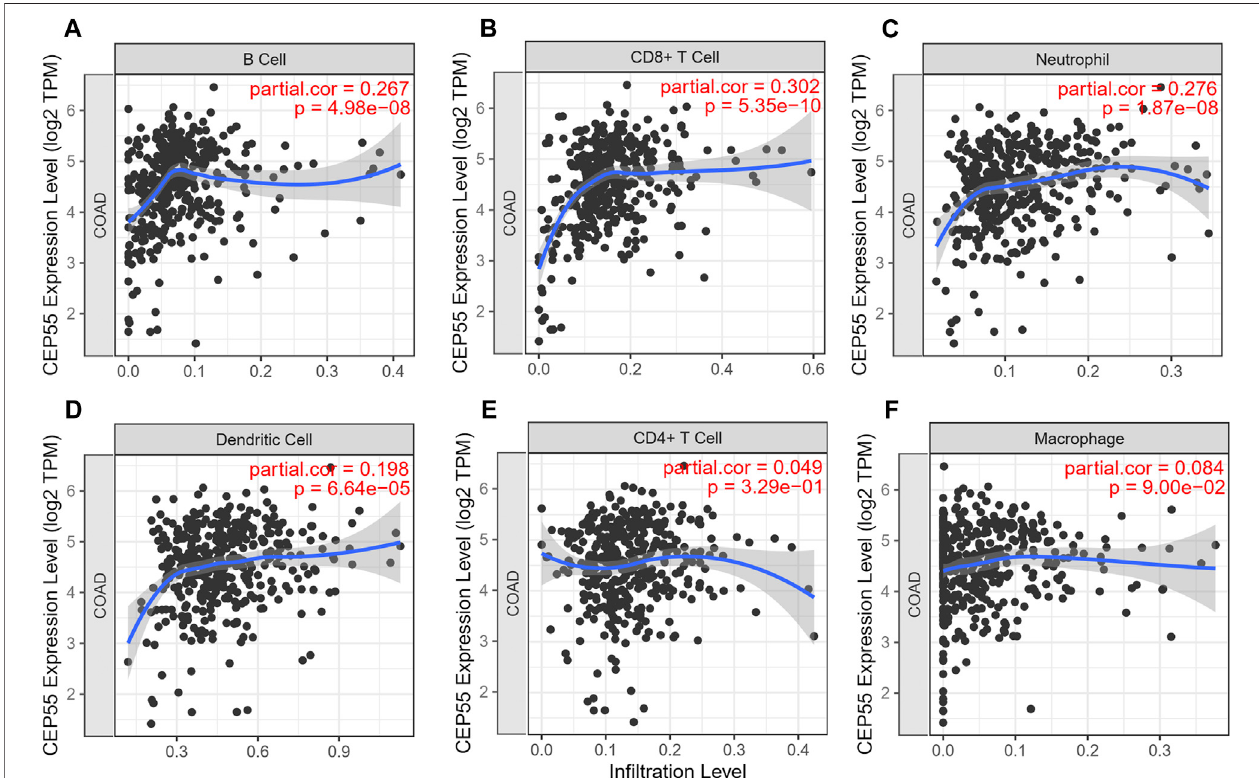
FIGURE 7 | The correlations of CEP55 mRNA expression with immune cell in fi ltration in CRC. (A) B cells, (B) CD8 + T cells, (C) neutrophils, (D) dendritic cells, (E) CD4 + T cells and (F) macrophages.